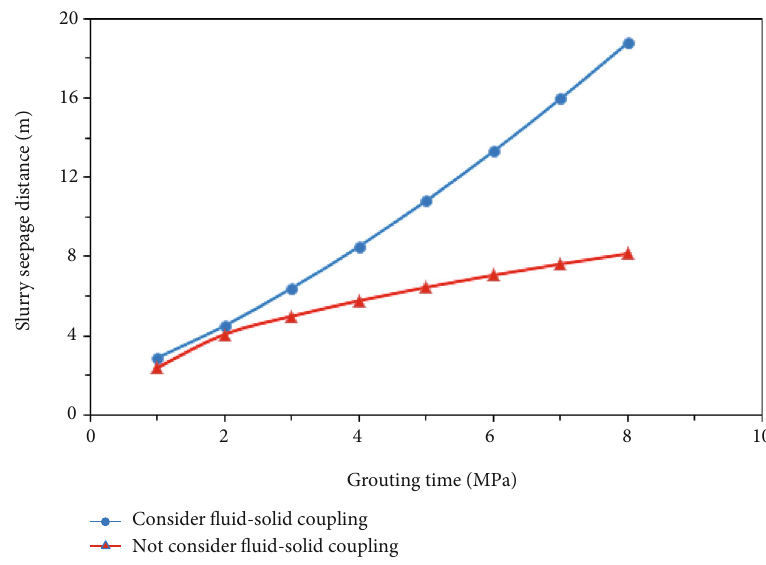
Figure 13: Slurry seepage distance under di ff erent grouting